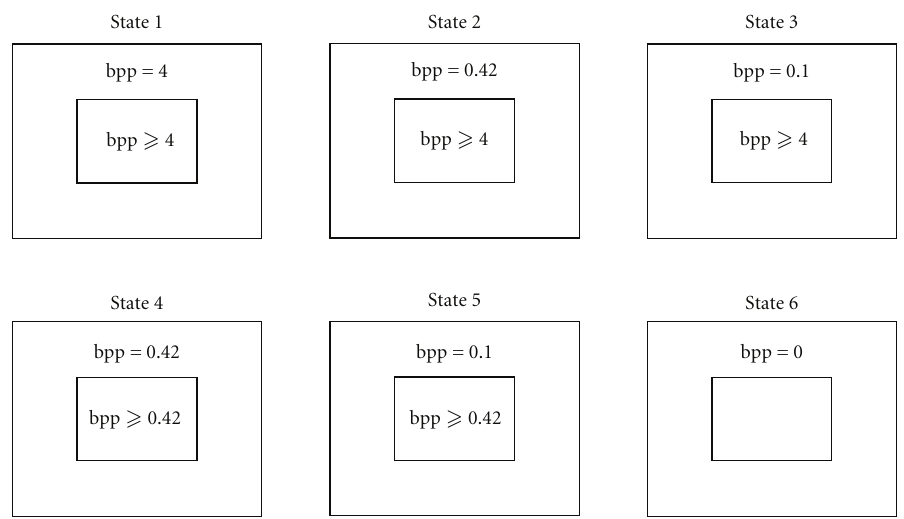
Figure 3: ROI and BKGRND bit per pixel density in states 1 through